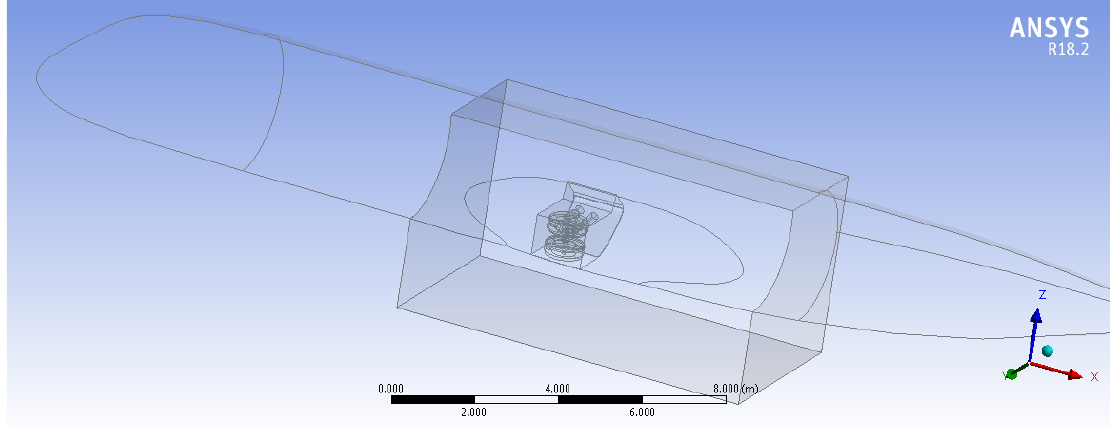
Figure 3. MLG: simplified geometric model including bay, door, gear strut, and